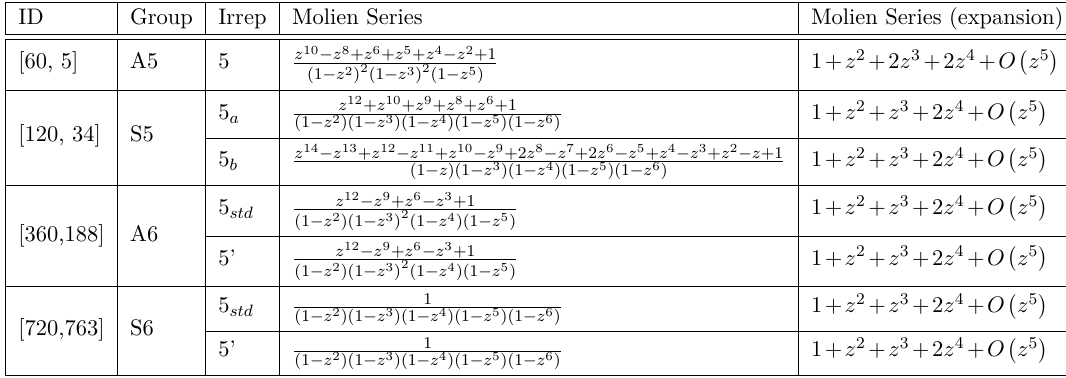
Table 4 . Finite groups and their irreducible representation that preserves a degree two invariant polynomial and at least one degree three invariant